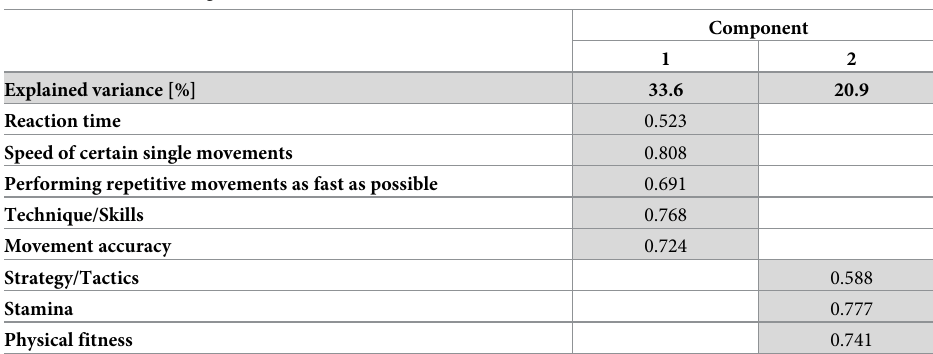
Table 25. Actual training